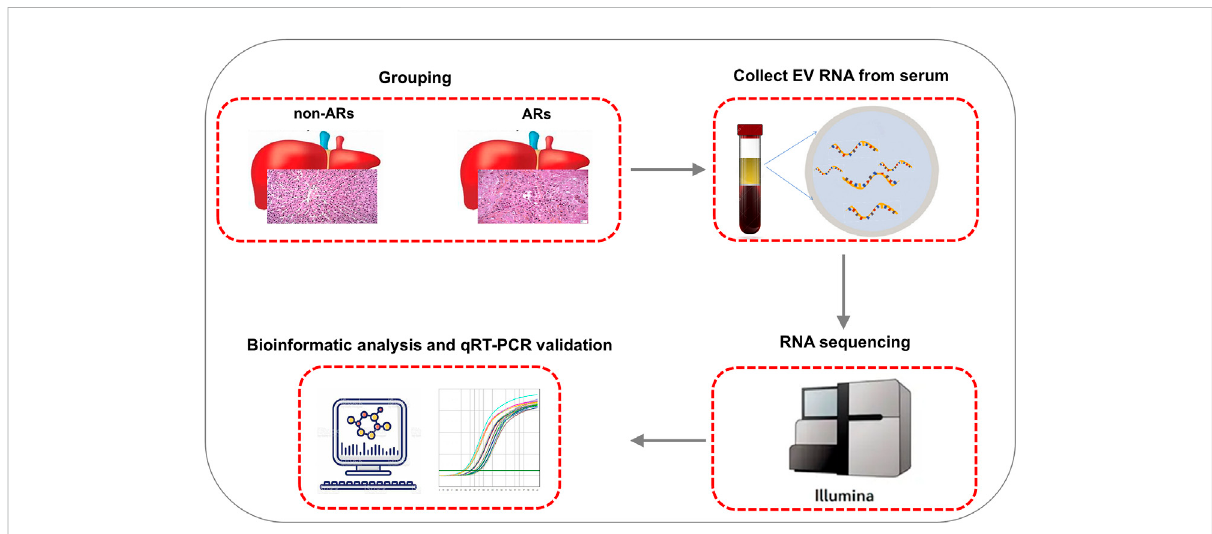
FIGURE 1 Schematic illustration of the work fl ow: From blood collection to analysis and